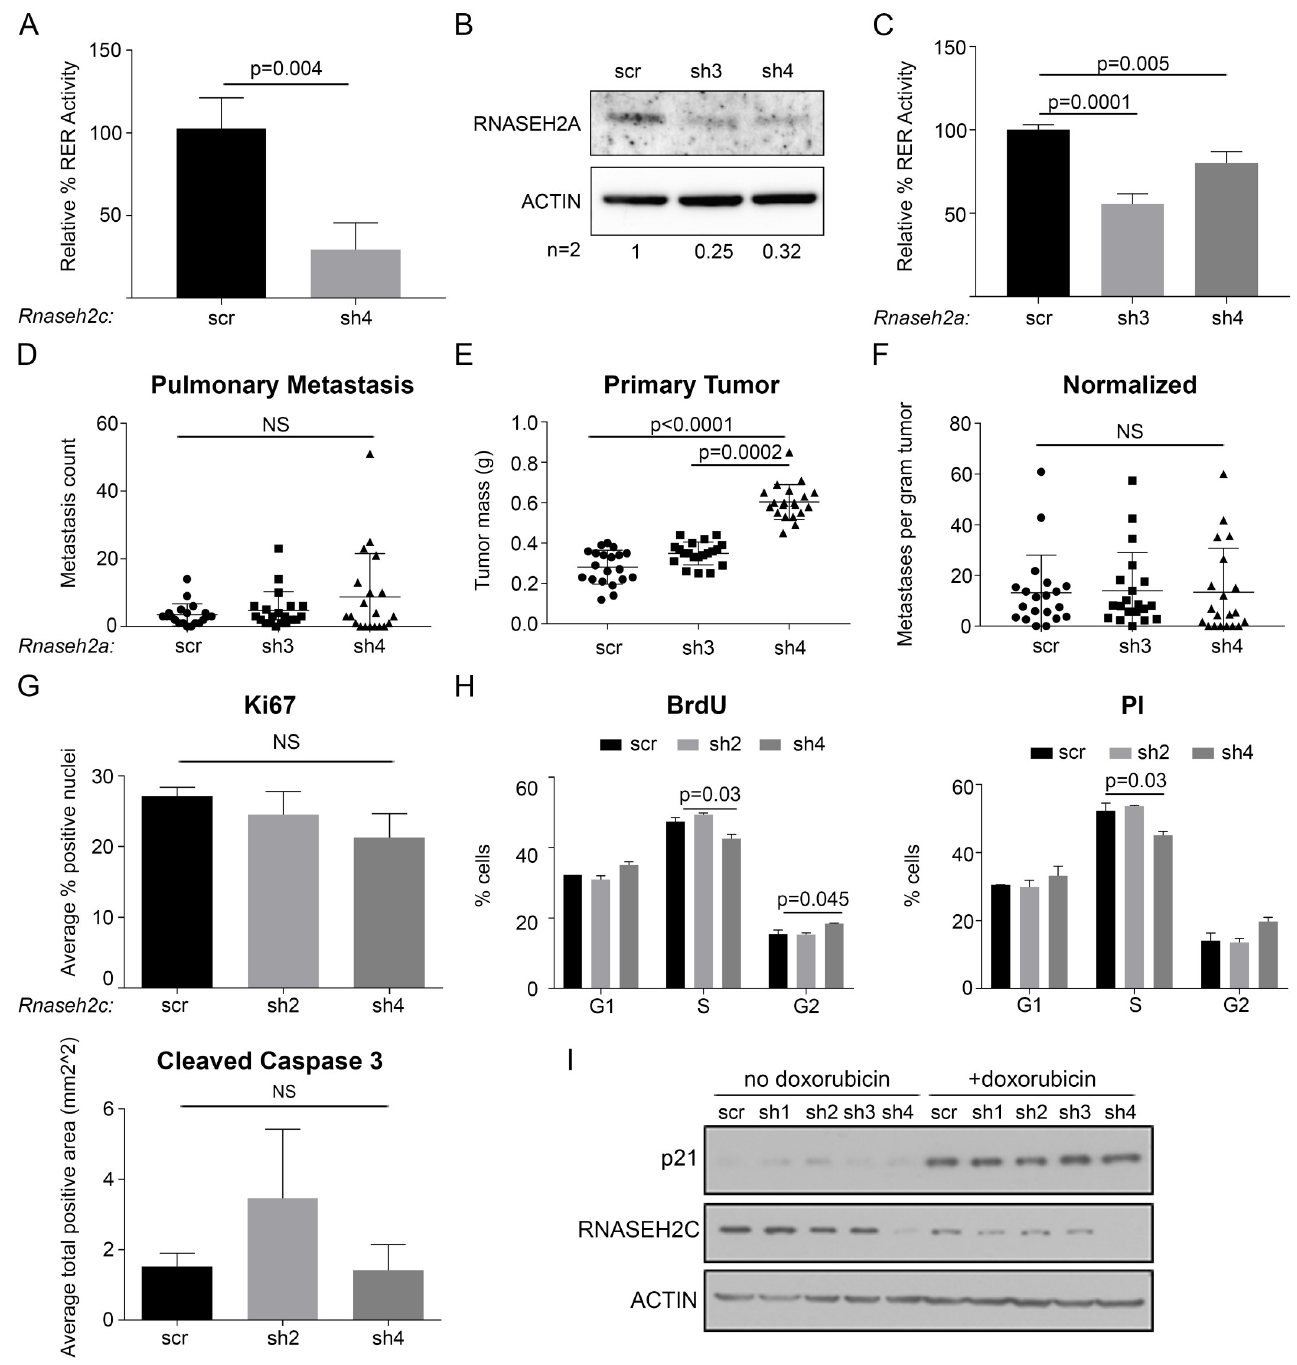
Fig 3. The metastatic effect of Rnaseh2c knockdown is not through enzyme activity. (A) Percent ribonucleotide excision repair (RER) activity was measured in Mvt1 scr and sh4 Rnaseh2c knockdown cells. Average ± standard deviation of three experiments. (B) RNASEH2A protein expression by western blot. One representative blot is shown, average relative densitometry for two independent experiments is reported below. (C) Percent ribonucleotide excision repair (RER) activity was measured in Mvt1 scr and Rnaseh2a knockdown cells. Average ± standard deviation of three experiments. (D-F) Control and Rnaseh2a knockdown cells were used in spontaneous metastasis assays. Pulmonary metastases (D) and tumor mass (E) were quantified at euthanasia and normalized (metastases per gram of tumor, F); average ± standard deviation, n = 20 mice per group in two independent experiments. (G) Quantification of Ki67 (top) and Cleaved Caspase 3 (bottom) staining by IHC of tumor sections as the average ± standard deviation of one section from each of three independent tumors. (H) Unsynchronized cells were labeled with BrdU (left) and stained with propidium iodide (PI, right) to analyze cell cycle progression. Average ± standard deviation of duplicate samples. (I) Cells ± doxorubicin treatment (1 μ M for 24 hr) were analyzed for p21 protein expression in response to DNA damage. NS—not significant.